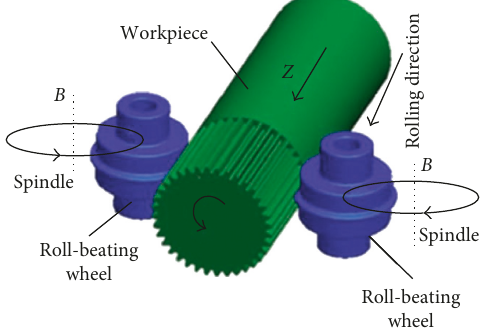
Figure 1: Schematic diagram of the HSCRB principle.